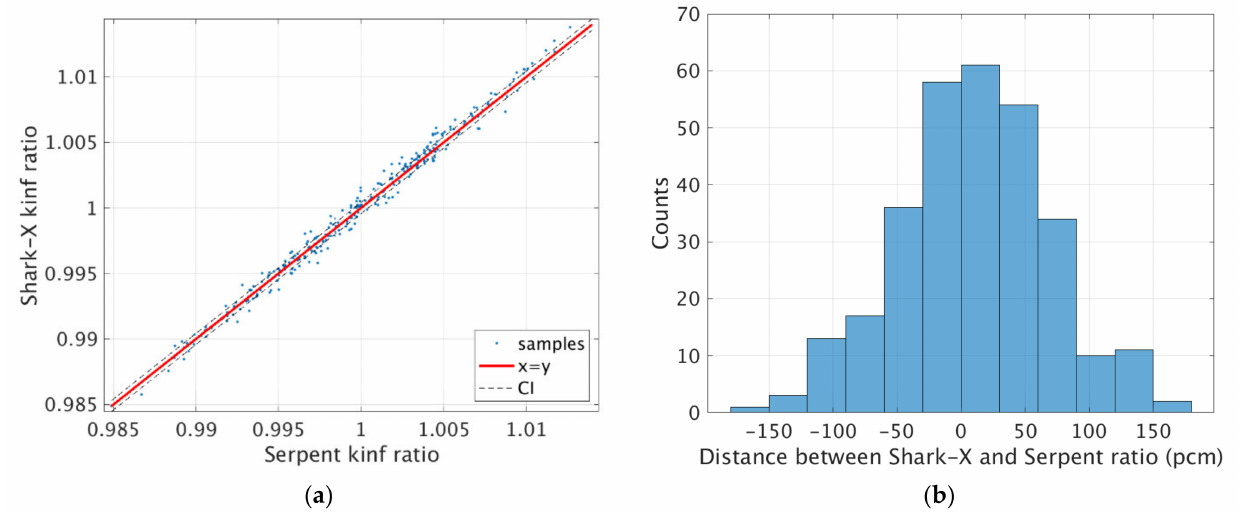
Figure 3. Illustration of the consistent sampling between Shark-X and Serpent: ( a ) ordered perturbation ratio; ( b ) fluctua- tions